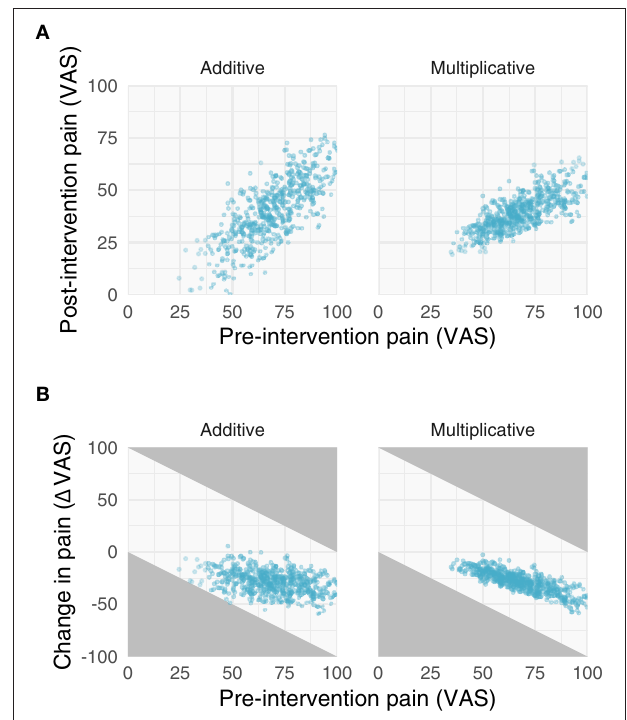
FIGURE 2 | Properties of additive and multiplicative data. We simulated data with additive (left) and multiplicative (right) assumptions. (A) Relationships between pre- and post-intervention pain scores when improvements are additive (left) and multiplicative (right). Note the additive post-intervention scores are relatively homoscedastic, while the variance of multiplicative post-intervention scores increases with increasing pre-intervention scores. (B) Negative relationships between change scores and pre-intervention scores. Gray areas in (B) represent regions where points are not possible due to measurement constraints; that is, because a change score cannot be > | 100 |